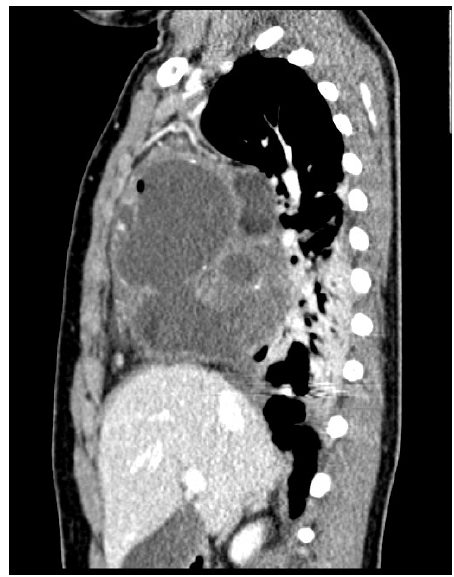
Figure 9. Sagittal CT scan of the chest. The diagnostic hypothesis based on the radiological findings was a cystic teratoma of the mediastinum or a cystic thymoma of the mediastinum. The patient underwent surgery under general anesthesia for the removal of the me- diastinal mass by sternotomy, and the tumor was successfully resected and sent for pa- thology. Histological examination was performed with hematoxylin and eosin staining, and diagnosis of a mediastinal germ cell tumor with the characteristics of a mature cystic teratoma was made. 3. Discussion The mediastinum is an anatomical compartment located in the center of the thorax in which numerous space-occupying masses may occur or become manifest, both in the adult and pediatric populations. For a long time, ultrasound was not considered a suitable method for the analysis of this anatomical compartment and the masses originating in it because the bone structures surrounding it anteriorly and posteriorly prevent ultrasound penetration. In recent years, however, thoracic ultrasound, and in particular lung ultra- sound, has emerged as a method for the study of the lung, not only in infectious disease but also for malformations, as in the case of congenital pulmonary airway malformation (CPAM), proving capable of identifying solid or cystic structures in the thorax, or more recently for the supportive diagnosis and follow-up of other chronic diseases affecting the lung such as asthma [7,8]. The presented case suggests a new possible application of lung ultrasound, which could be used as a supporting method also in the diagnosis of some mediastinal masses, such as teratoma. Primary mediastinal teratoma is a relatively rare tumor, with cystic or solid appear- ance or a combination of the two and histologically composed of tissues derived from the three embryonic leaflets and foreign to the organ or anatomical site from which they orig- inate [9]. Most teratomas, especially at pediatric age, are defined as mature teratomas and have a benign behavior. In contrast, immature teratomas, characterized by the presence of neu- roectodermal-derived tissues, have an increased risk of malignancy and higher rates of local recurrence [10].